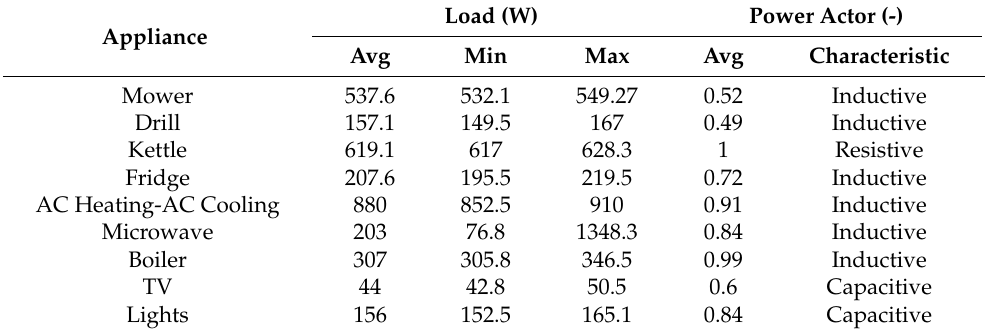
Table 1. Measured electrical characteristics of the appliances used in the experiment